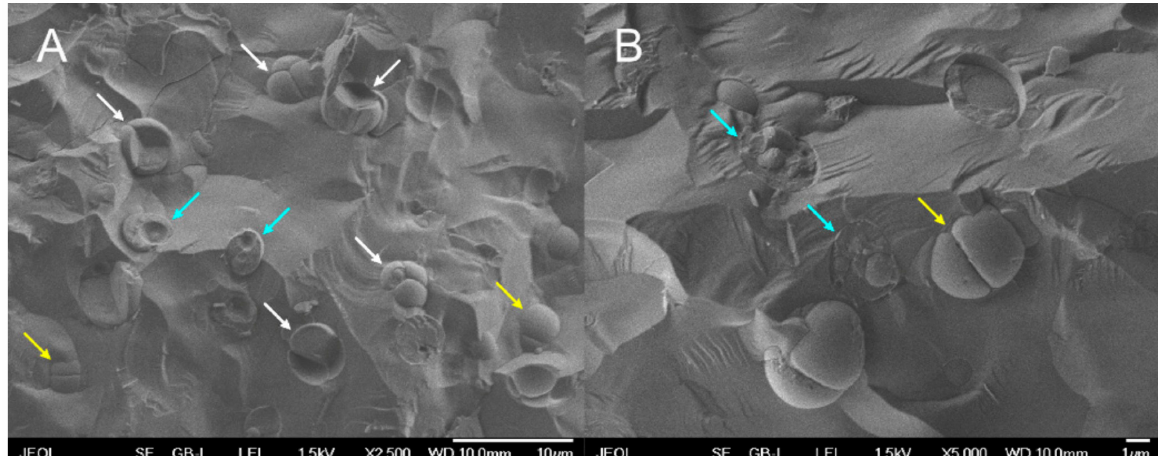
Figure 6. Photomicrographs of the asynchronous culture of Galdieria sulphuraria grown under optimal conditions (500 µ mol photons m − 2 s − 1 , 40 ◦ C, pH 3) and visualized using a cryo-scanning electron microscope (cryo-SEM). Single daughter cells-cyan arrows, mother cells divided into 2 daughter cells-yellow arrows, mother cells divided into 4 daughter cells-white arrows ( A , B ). The bar represents 10 µ m in ( A ) and 1 µ m in ( B